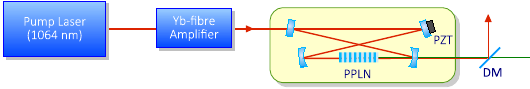
Figure 2: Schematic view of the experimental setup. An amplified 1064 nm laser pumps a bow-tie nonlinear cavity with a periodically poled crystal inside. The output radiation is frequency separated and sent to the respective diagnostics, not shown (see text for de-